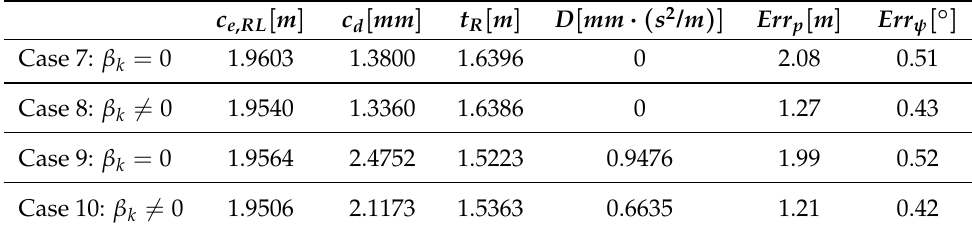
Table 2. Parameters and errors of the motivation example cases